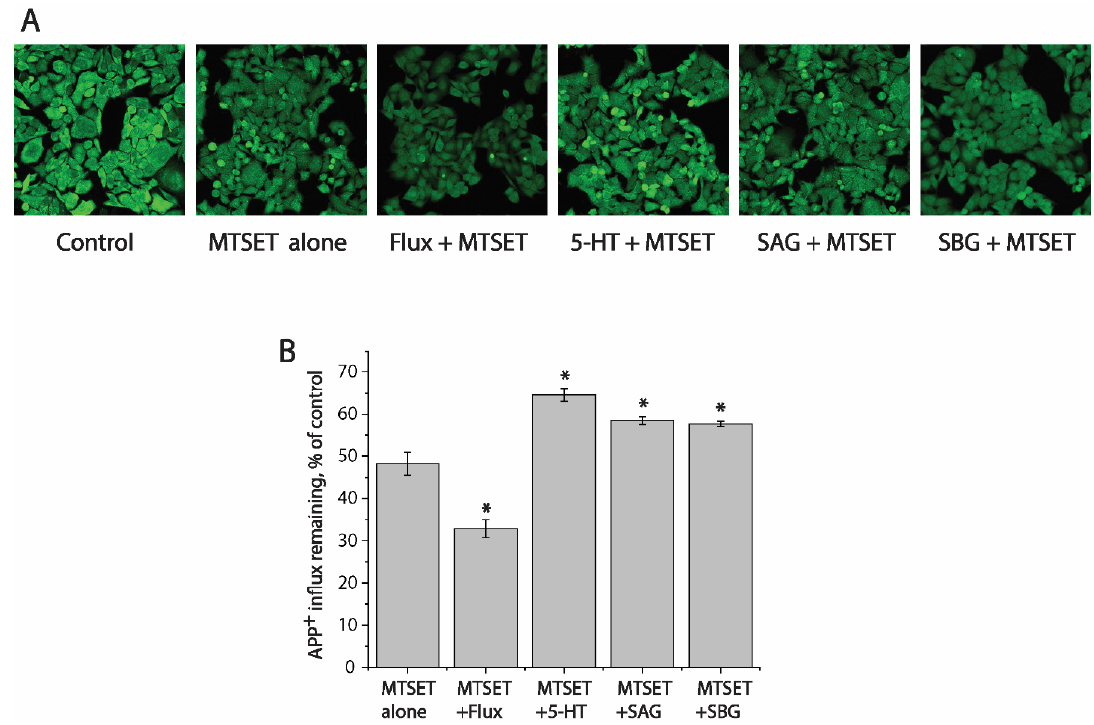
Figure 6. Effects of SAG and SBG on SERT conformation. ( A ) Representative images of accumulated APP + in cells expressing Y107C mutant after treatment without (control) or with MTSET in the absence (MTSET alone) or presence of 10 μ M fluoxetine (MTSET + flux), 10 μ M SAG (MTSET + SAG), or 16 μ M SBG (MTSET + SBG). The experiment was repeated twice more with similar results. ( B ) Quantitative analysis for APP + influx after treatment with indicated drugs in the absence or presence of MTSET, expressed as a percentage of that measured in the absence of MTSET (control). In each experiment, at least ten cells were randomly selected for quantitative analysis. Accumulated APP + fluorescence was counted and normalized to the cell areas. All error bars represent the SEM (n = 3). Asterisks indicate statistically significant changes ( p < 0.05) in the accumulated APP + fluorescence compared with the MTSET alone using Student’s t test.